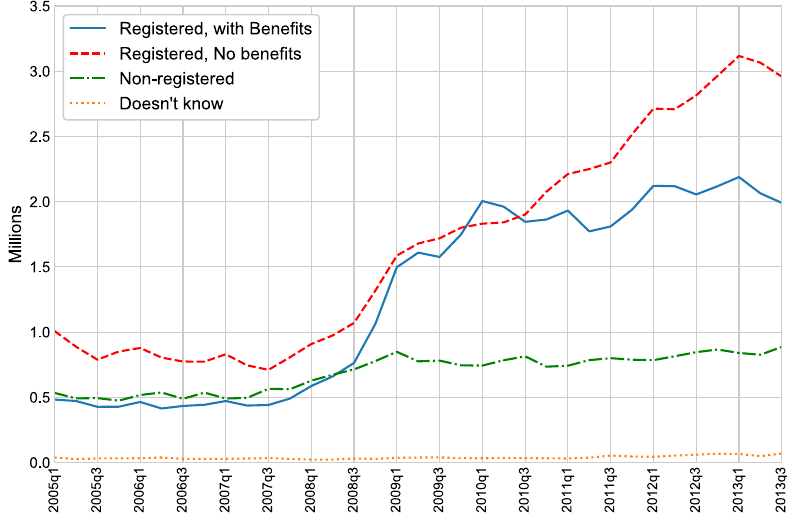
Fig. 16 Relationship with the Employment Office. Source :